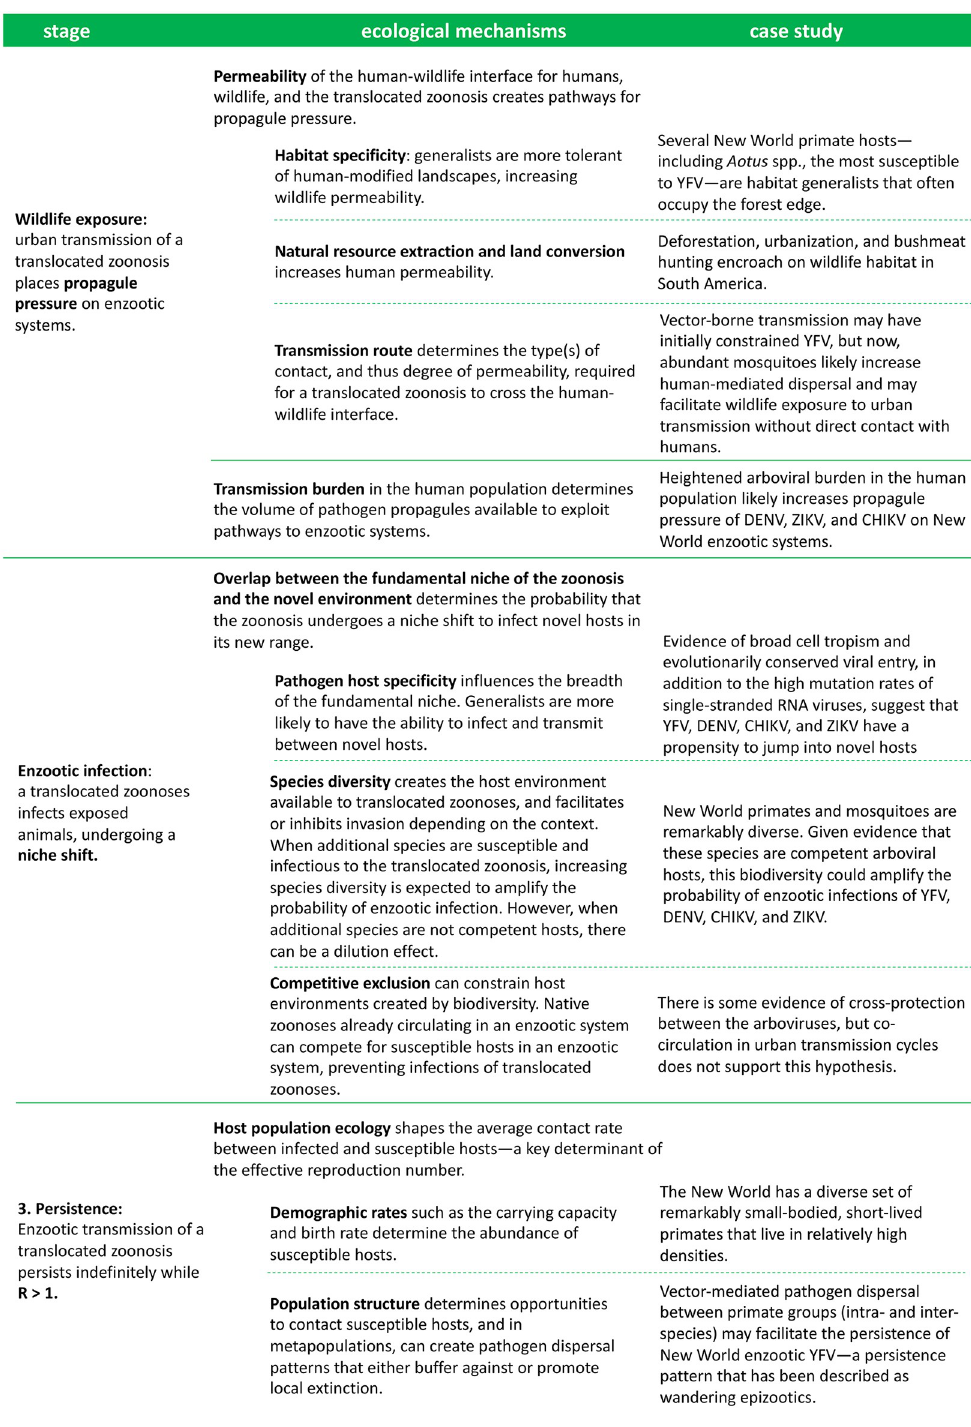
Fig 2. An outline of the ecological mechanisms affecting each stage of enzootic establishment, and their influence on the enzootic potential of translocated arboviruses in the neotropics.